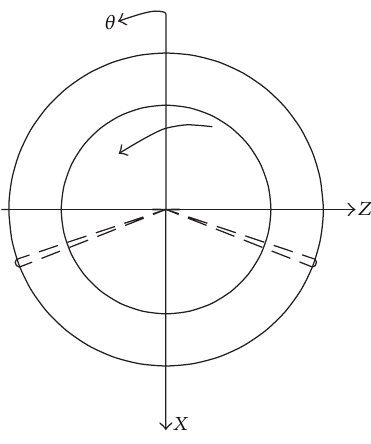
Figure 5: Dn-Dn configuration of two-groove oil journal bearing.